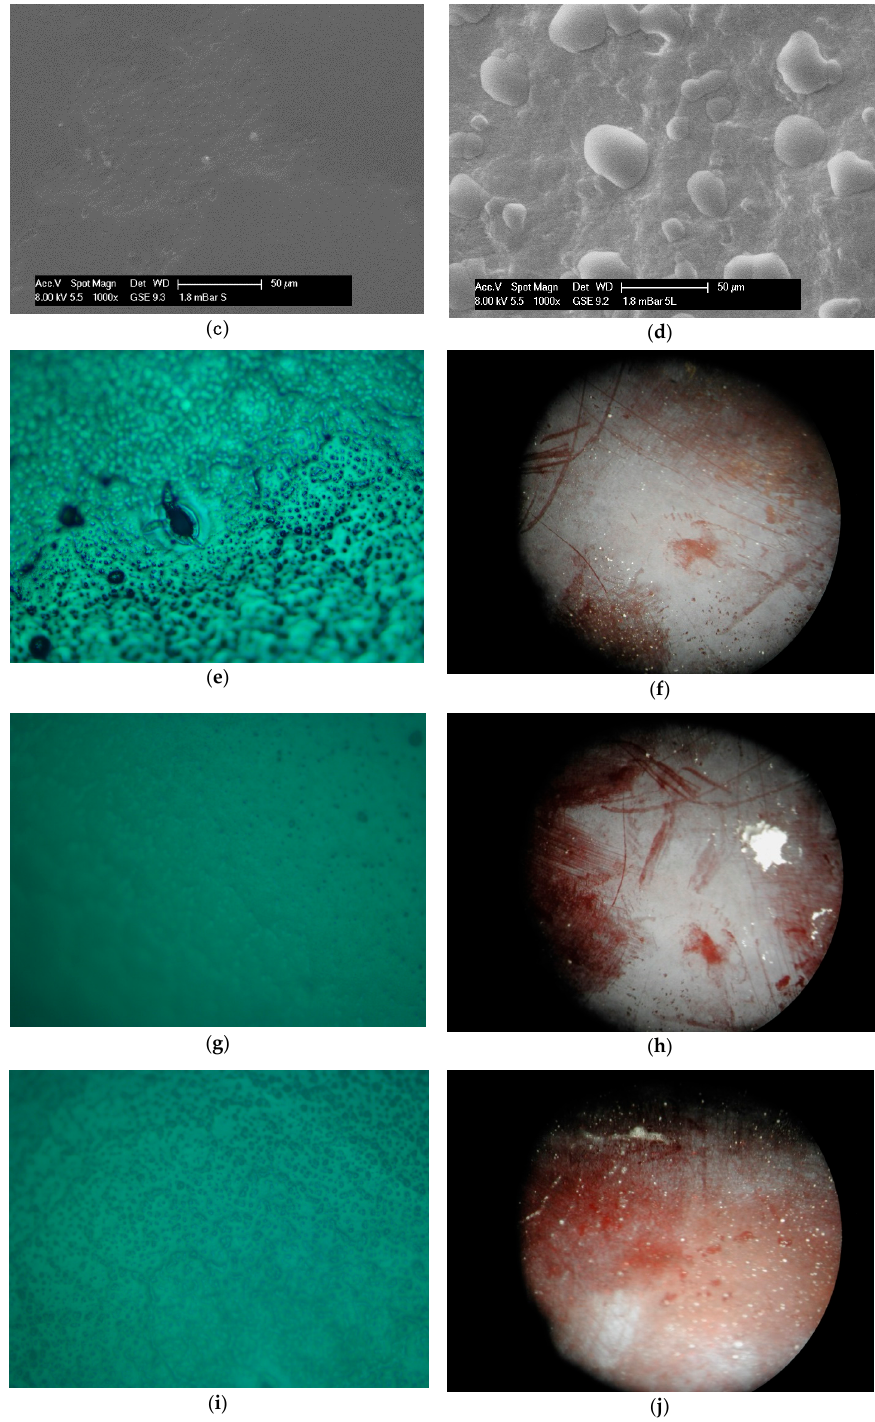
Figure 1. ESEM micrograph of: ( a ) cross section of starch-whey protein (80 / 20) films (magnification 1000 × ), ( b ) cross section of starch-based films (magnification 1000 × ), ( c ) surface exposed to air during drying of starch-based films (magnification 1000 × ), ( d ) surface exposed to air during drying of starch-based films with rapeseed oil addition (magnification 1000 × ); Polarizing microscopy image of: ( e ) surface of raw plum (magnification 200 × ), ( g ) plum surface after dipping in starch-based coating (magnification 200 × ); ( i ) plum surface after 1 h from dipping in starch-based coating (magnification 200 × ); Light microscopy graph of: ( f ) surface of raw plum (magnification 20 × ), ( h ) plum surface after dipping in starch-based coating (magnification 20 × ), ( j ) plum surface after 1 h from dipping in starch-based coating (magnification 20 ×